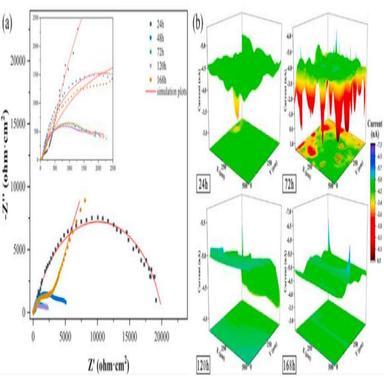
(a) Nyquist plots and (b) SECM mappings of the AO sample during immersion in SBF.